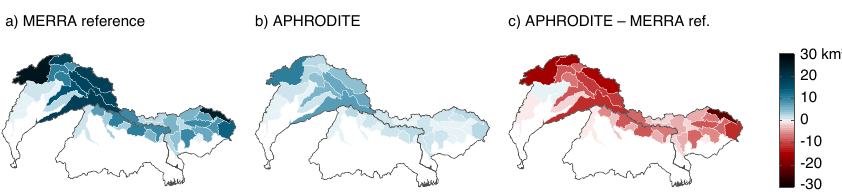
Figure 4. The effect of bias corrections with APHRODITE temperature and precipitation: (a) MERRA reference snowfall, (b) snowfall based on bias corrections with APHRODITE, (c) APHRODITE (b) minus MERRA reference snowfall (a)